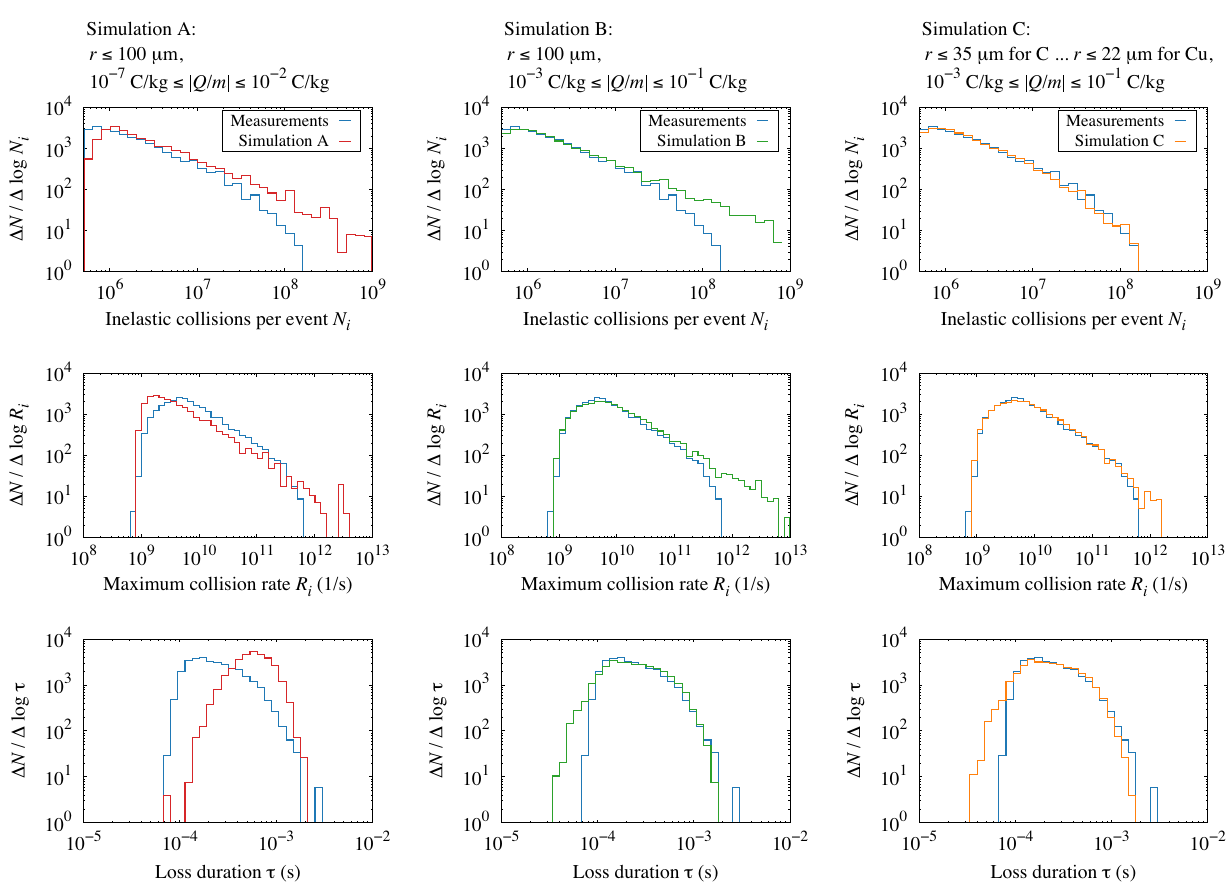
FIG. 10. Measured and simulated distributions of dust-induced loss events as a function of collisions per event (top), maximum collision rate (center), and loss duration (bottom). The measurements are the same as in Fig. 9, including about N ¼ 5500 events. The simulation results correspond to different intervals of j Q=m j and different maximum radii (see top of the